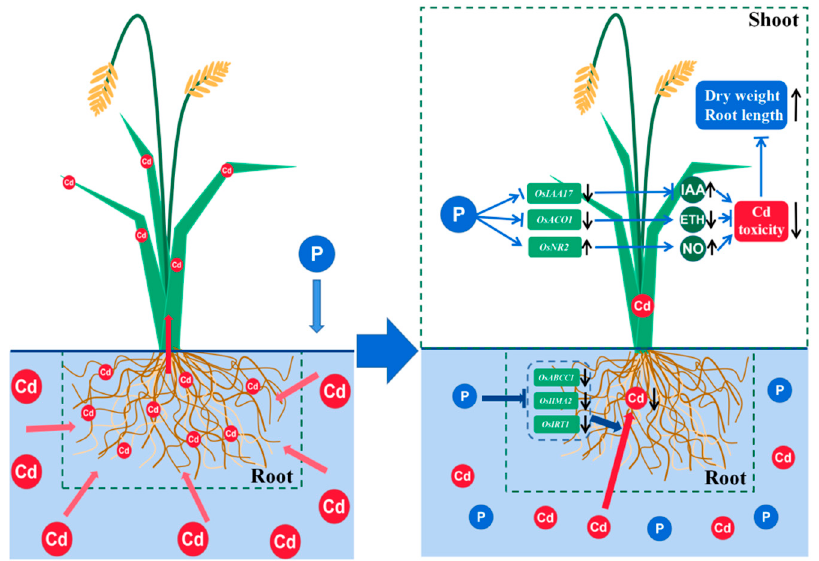
Figure 8. Possible mechanisms for the phosphorus reduction of cadmium toxicity in